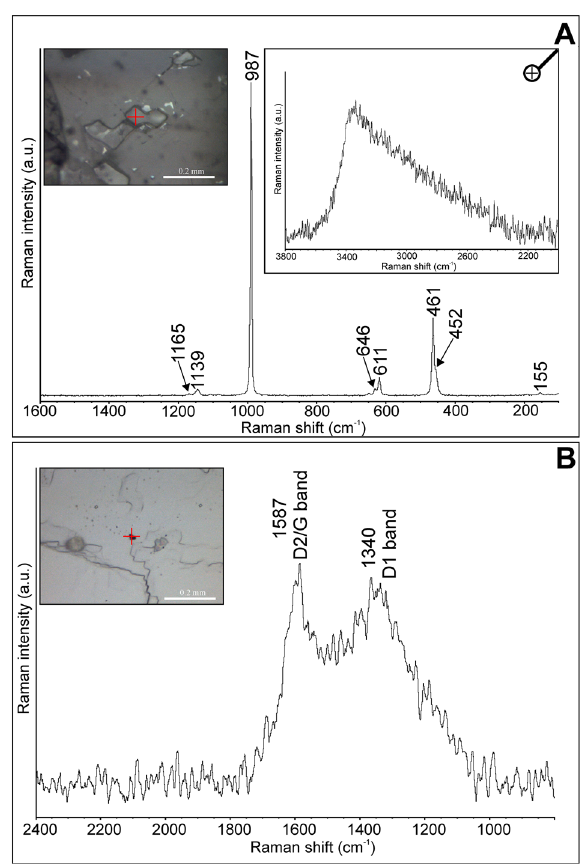
Figure 10. Microphotos and Raman spectra collected for: ( A ) fluid inclusions in barite. Note that most bands correspond to the host mineral; the presence of water in fluid inclusions is indicated by a broad band about 3300 cm −1 (see inset); ( B ) small inclusions of organic matter; note that D band refers to disordered carbon, whereas G bands is related to in-plane stretching vibrations of between sp2 carbon